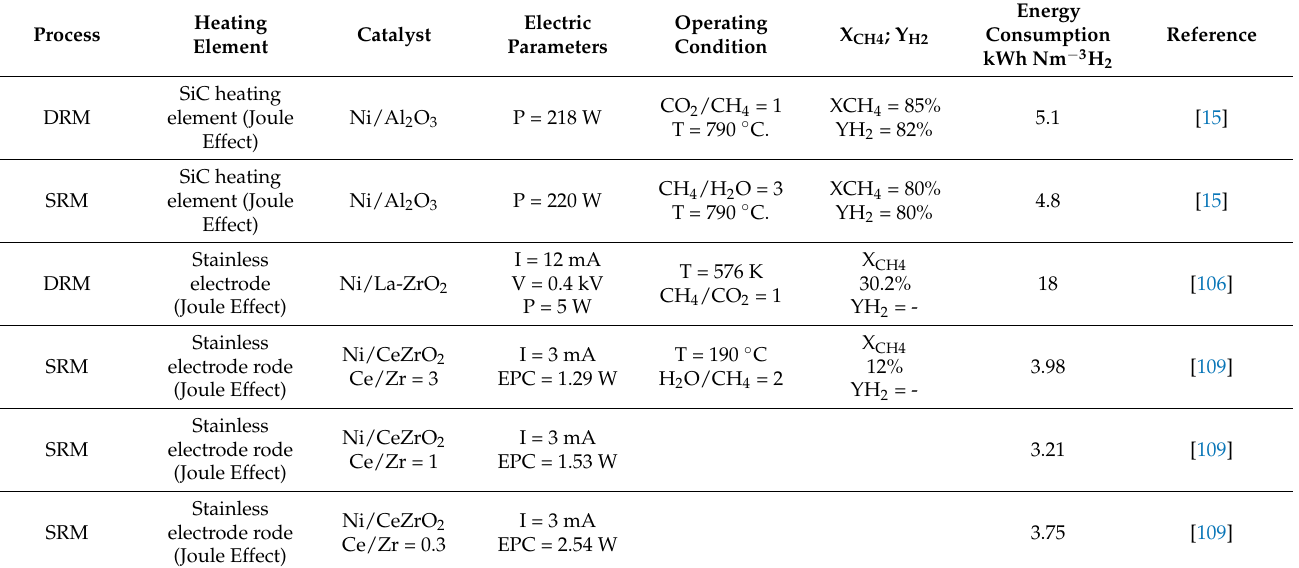
Table 3. Energy consumption among the electrified-structured catalyst proposed in literature for electrified reforming processes and their operating